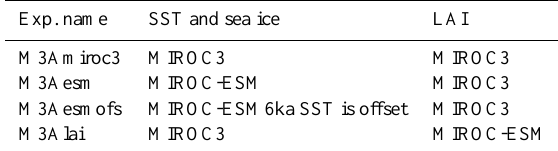
Table 3. Sensitivity experiments using the AGCM of MIROC3. Exp. name